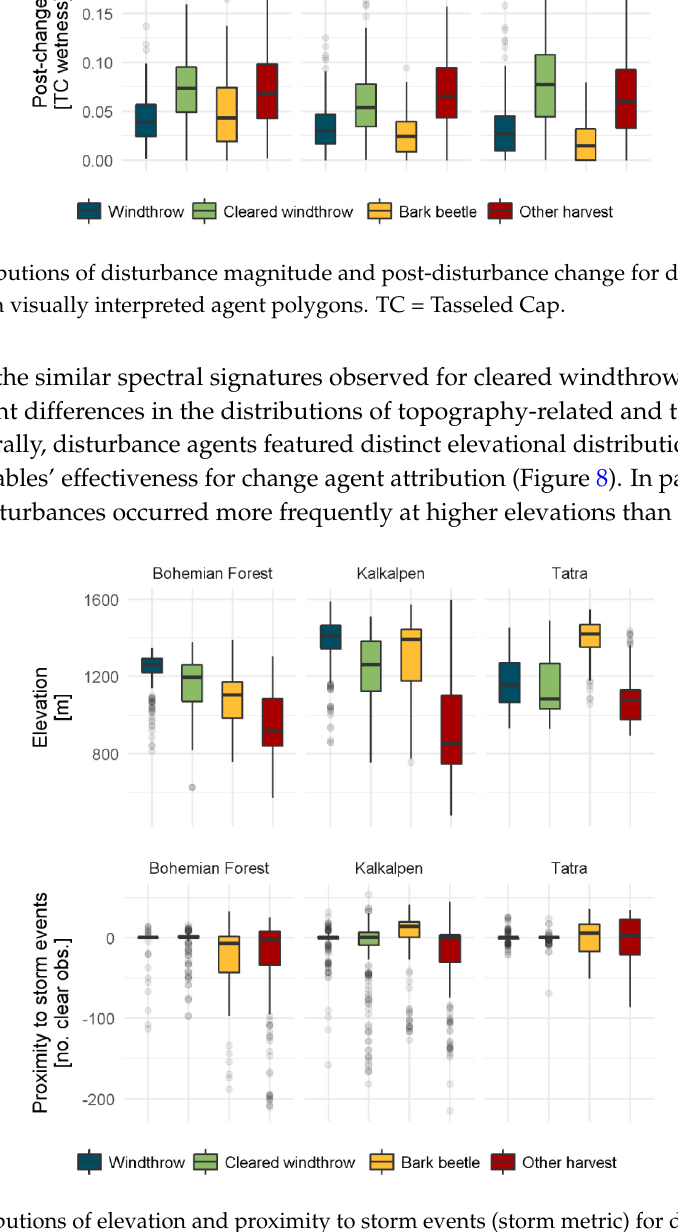
Figure 8. Distributions of elevation and proximity to storm events (storm metric) for disturbance agent classes based on visually interpreted agent polygons.